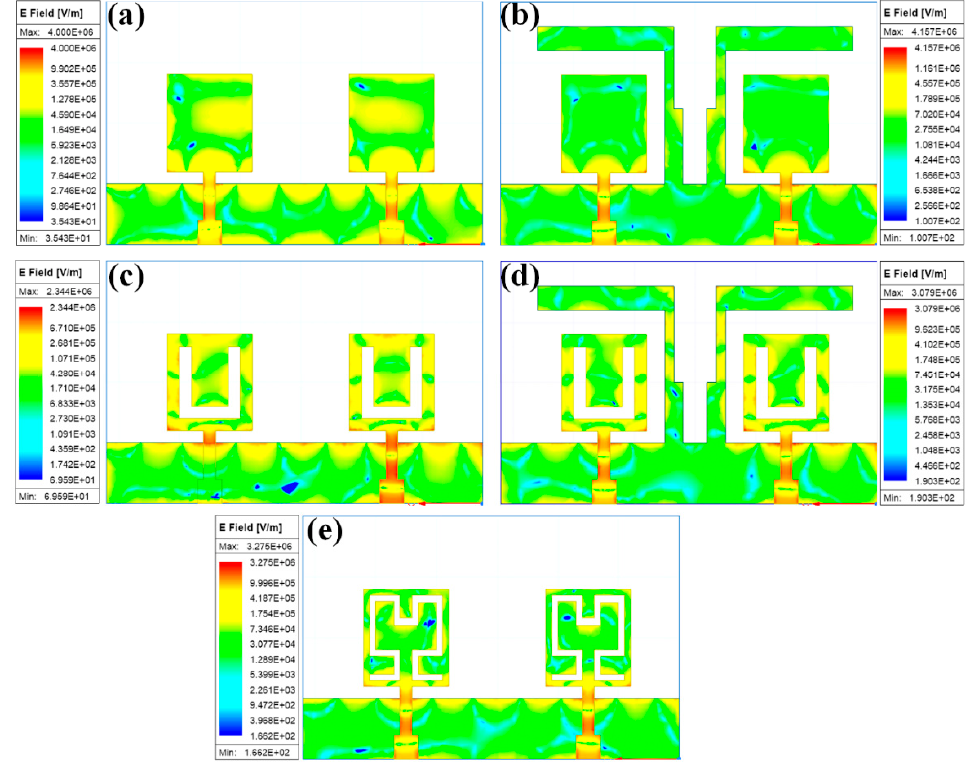
Figure 16. Normalized electric field distribution for the different ( a ) Design 1, ( b ) Design 2, ( c ) Design 3, ( d ) Design 4, and ( e ) Design 5 structures of the proposed antenna.